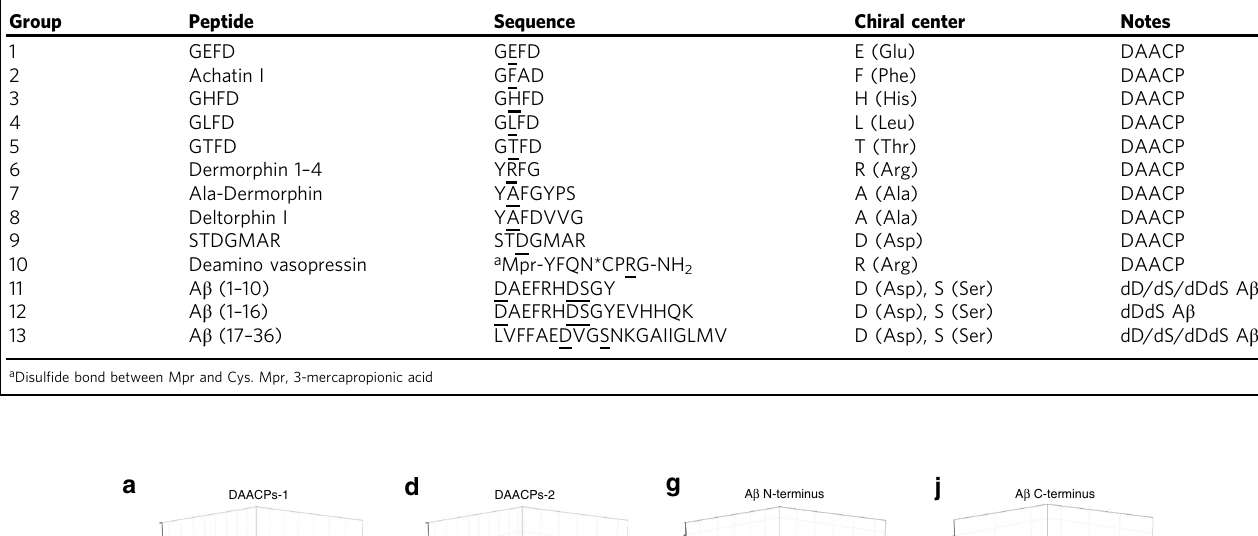
Table 1 Information for 30 chiral peptides (13 groups) including neuropeptides with single D-amino acid (DAACPs) and A β with D-isomerized Asp and Ser-residues (dD/dS A β )